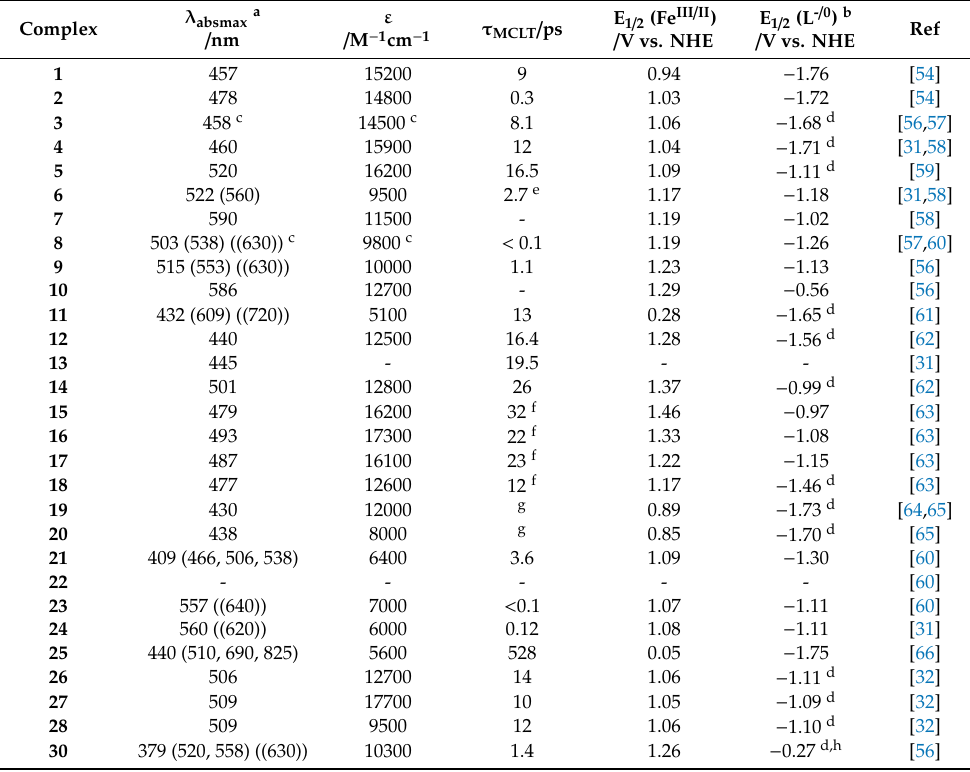
Table 1. Photo(electro)chemical properties of Fe(II)NHC complexes. All measurements in CH 3 CN and with PF 6 counterions unless otherwise noted. Electrochemical measurements conducted in CH 3 CN against Fc +/ 0 and converted to corresponding standard NHE values using a standard reference electrode conversion constant of + 0.630 V [55].